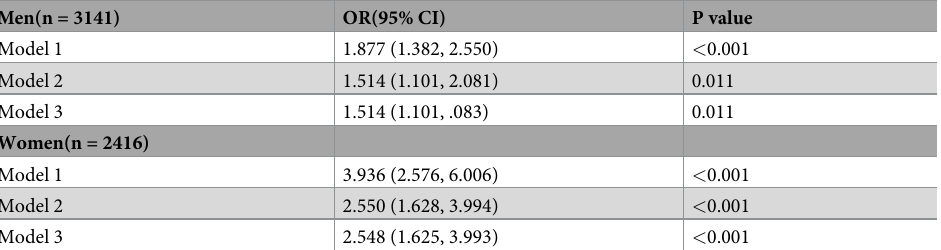
Table 4. Risks of diverticulosis between percentage of body fat and genders (according to gender-specific cut-off